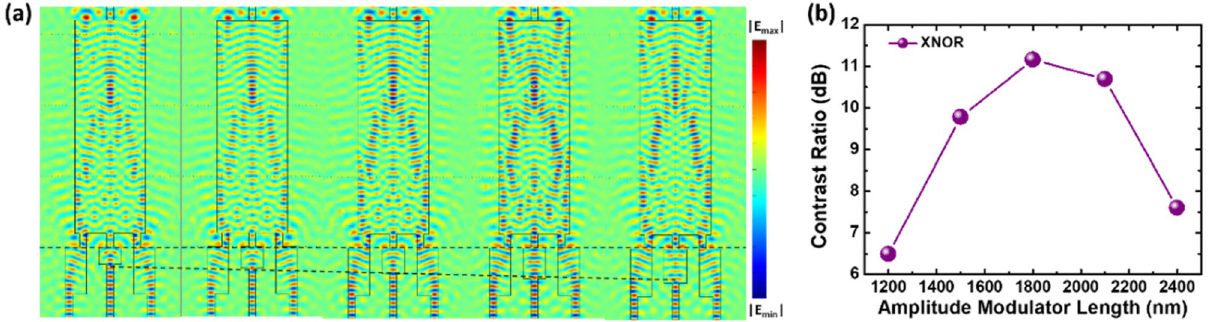
Figure 4. ( a ) E z -field distribution of the XNOR gate in the “on” state. The length of the amplitude modulator on the Ref port is varied as indicated by the black dashed lines. ( b ) Relation of contrast ratio as the function of amplitude modulator